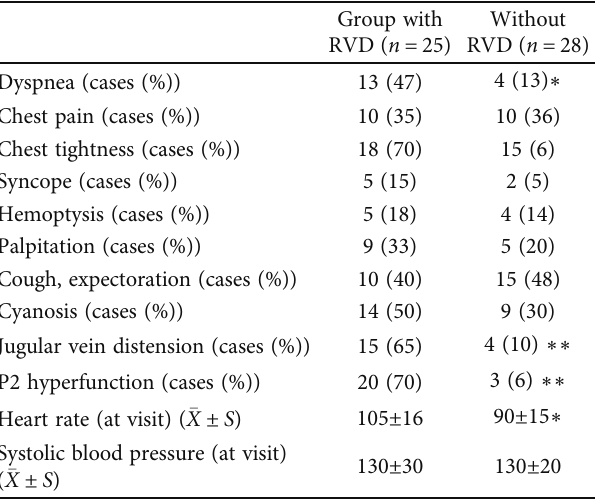
Table 2: General clinical data of 53 normotensive patients with pulmonary embolism.